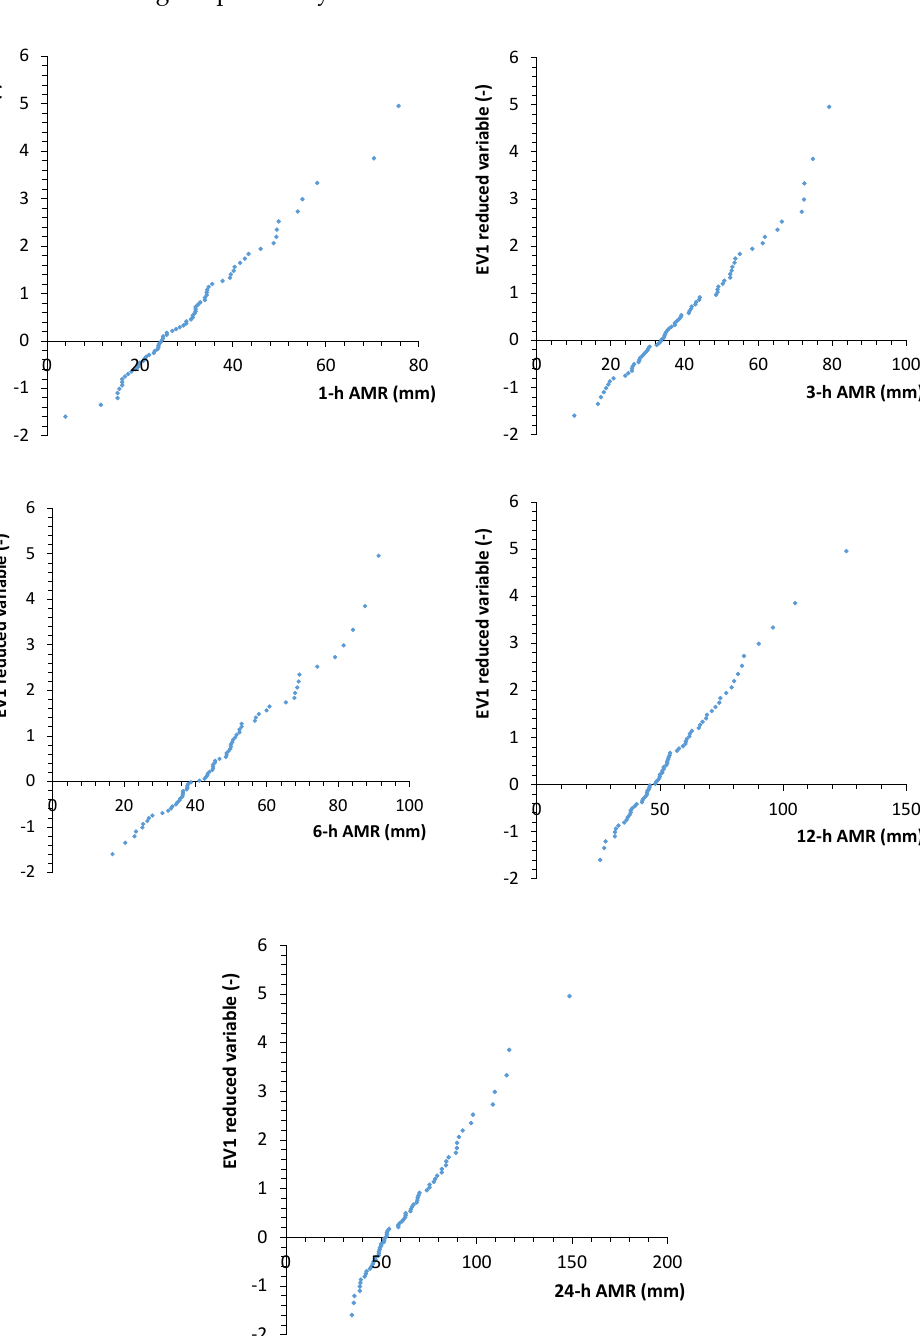
Figure 4. Viterbo rain gauge: observed AMR series on EV1 probabilistic plots.